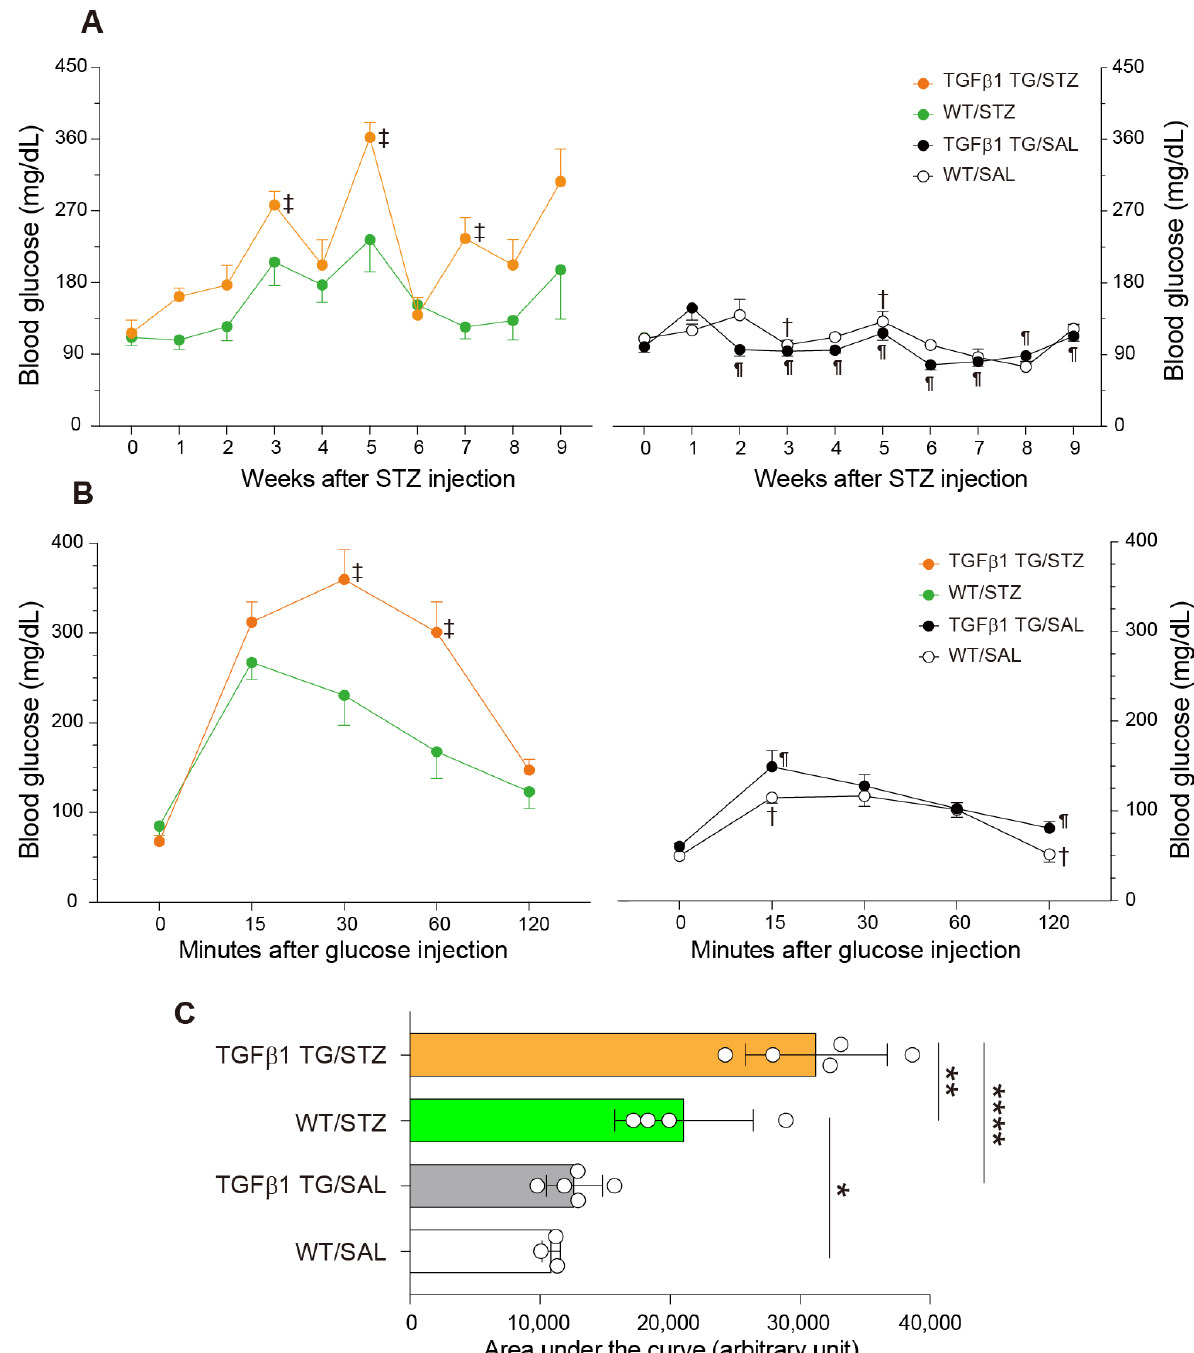
Figure 2. Mice overexpressing transforming growth factor β 1 show insulin resistance. Mice received intraperitoneal injections of streptozotocin (STZ) for five days and were then sacrificed after 9 weeks. The control mice received intraperitoneal injections of saline for the same interval and schedule. ( A ) Blood glucose levels were measured every week for 9 weeks, as described in the Materials and Methods. ( B ) An intraperitoneal glucose tolerance test was performed, as described in the Materials and Methods. ( C ) The area under the curve during the intraperitoneal glucose tolerance test was calculated. Number of mice: n = 3 in WT/SAL, n = 5 in TGF β 1 TG/SAL, n = 4 in WT/STZ, n = 5 in TGF β 1 TG/STZ. Data are the mean ± S.D. Statistical analysis by ANOVA with Newman – Keuls ’ test or Kruskal – Wallis ANOVA with Dunn’s test. ¶ p < 0.05 vs. TGF β1 TG/STZ; ‡ p < 0.05 vs. WT/STZ; † p < 0.05 vs. WT/STZ; * p < 0.05; ** p < 0.01; **** p < 0.0001.